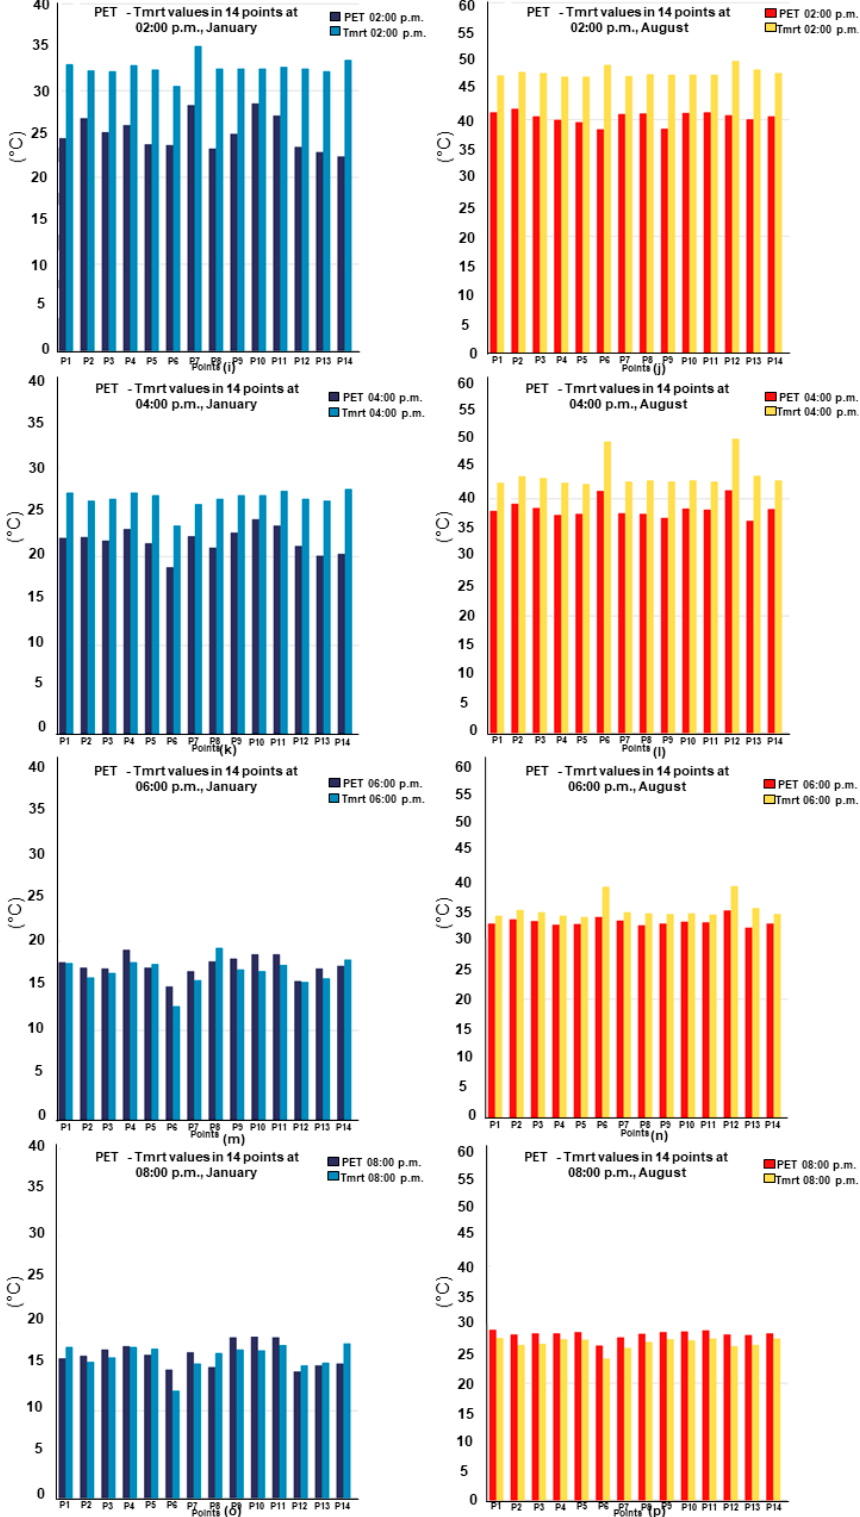
Figure 8. Assessment of PET and Tmrt levels at 14 studied points during January ( a , c , e , g , i , k , m , o ) and August 2021 ( b , d , f , h , j , l , n , p ) from 6:00 a.m. to 8